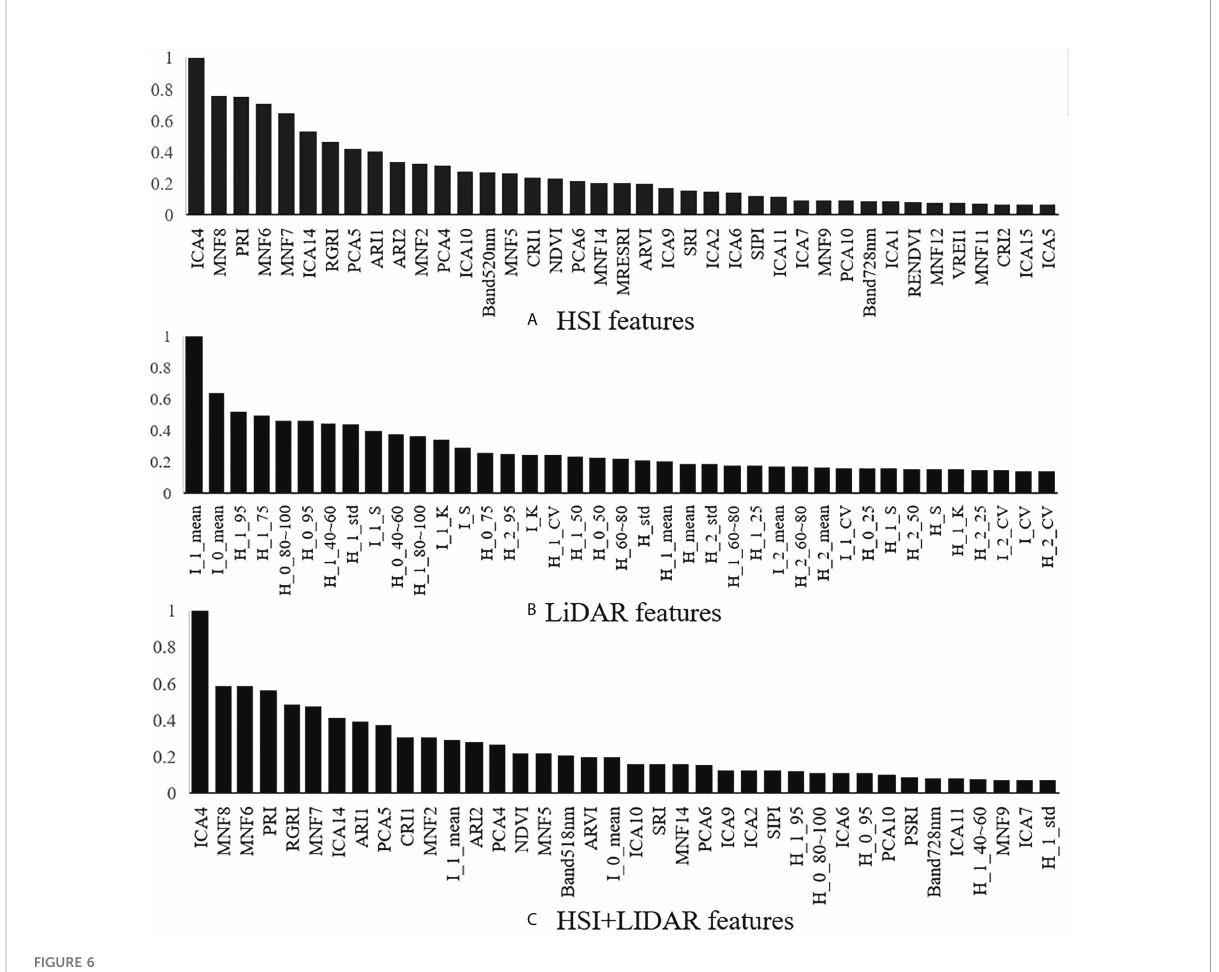
FIGURE 6 The ranking of features based on importance.